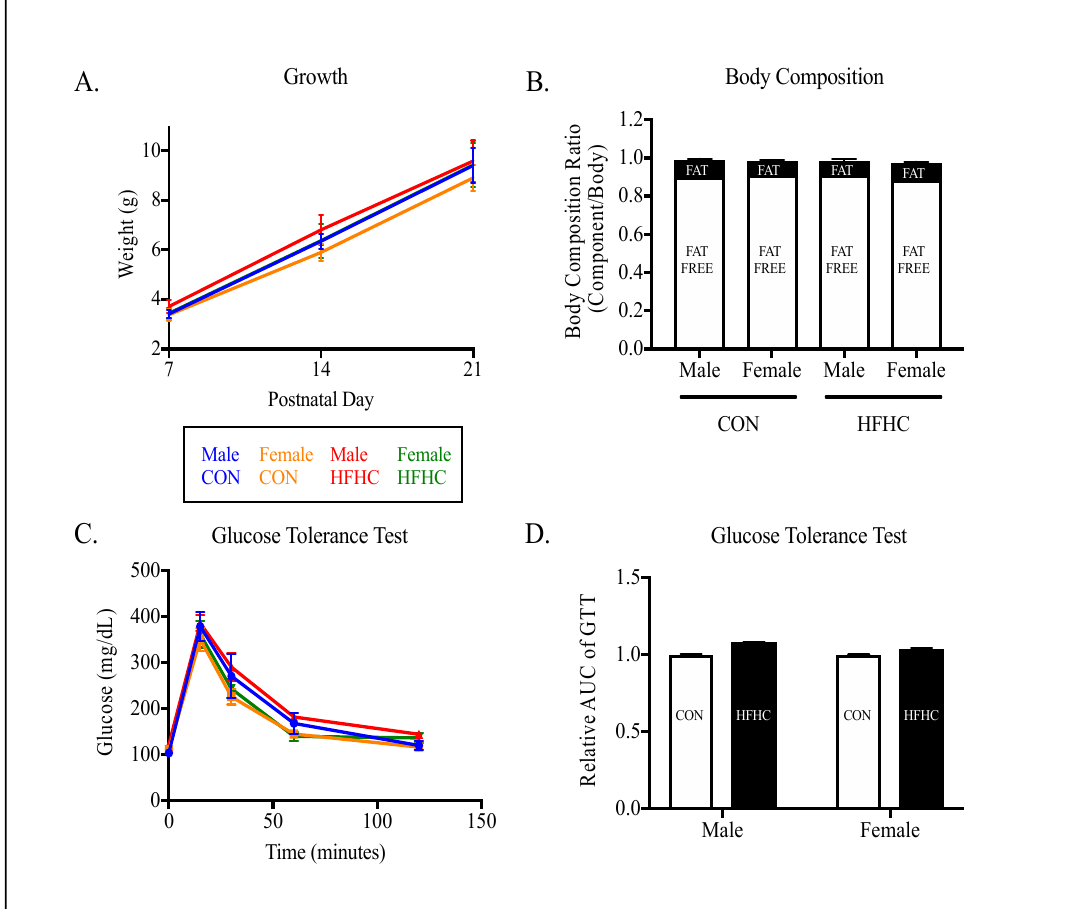
Figure 2. Offspring metabolic phenotype following maternal high-fat–high-carbohydrate (HFHC)- Figure 2. O ff spring metabolic phenotype following maternal high-fat–high-carbohydrate diet-induced obesity . Male and female growth was followed weekly through PN21 (Panel A ; n = 5– (HFHC)-diet-induced obesity. Male and female growth was followed weekly through PN21 8/group). Body composition (% fat free mass, % fat mass, Panel B ; n = 4–6/group) and glucose ( A ; n = 5–8 / group). Body composition (% fat free mass, % fat mass, B ; n = 4–6 / group) and glucose tolerance test (Panel C ; n = 14–16/group) were performed post-weaning in offspring born to control tolerance test ( C ; n = 14–16 / group) were performed post-weaning in o ff spring born to control (CON) (CON) and high-fat–high-carbohydrate (HFHC) dams. There were no significant differences between and high-fat–high-carbohydrate (HFHC) dams. There were no significant di ff erences between o ff spring offspring growth (Panel A ), adiposity (Panel B ), or glucose tolerance (Panel D ). Results are expressed growth ( A ), adiposity ( B ), or glucose tolerance ( D ). Results are expressed as mean ± SEM. AUC—area as mean ± SEM. AUC—area under the curve; unpaired t -test or two way ANOVA; CON—offspring under the curve; unpaired t -test or two way ANOVA; CON—o ff spring born to dams maintained on born to dams maintained on control diet; HFHC—offspring born to dams maintained on high-fat– control diet; HFHC—o ff spring born to dams maintained on high-fat–high-carbohydrate diet; blue line high-carbohydrate diet; blue line represents male CON offspring, red line represents male HFHC represents male CON o ff spring, red line represents male HFHC o ff spring, yellow line represents female offspring, yellow line represents female CON offspring, green line represents female HFHC offspring. CON o ff spring, green line represents female HFHC o ff spring. B —open bar represents % fat free Panel B —open bar represents % fat free mass, closed bar represents % fat mass. Panel D —open bar mass, closed bar represents % fat mass. D —open bar represents CON o ff spring, closed bar represents represents CON offspring, closed bar represents HFHC offspring. HFHC o ff